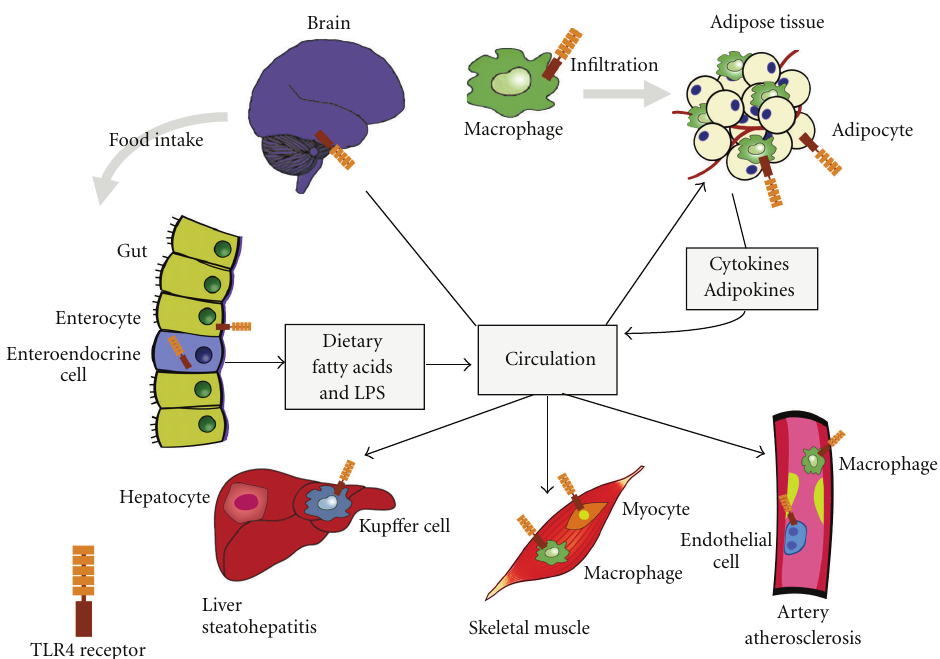
Figure 2: Distribution of TLR4 expression in the integrated organ/tissue systems that modulate energy homeostasis and insulin sensitivity. Schematic representation of the cross-talk between tissues. Adipose tissue shown in the macrophage-enriched, inflamed